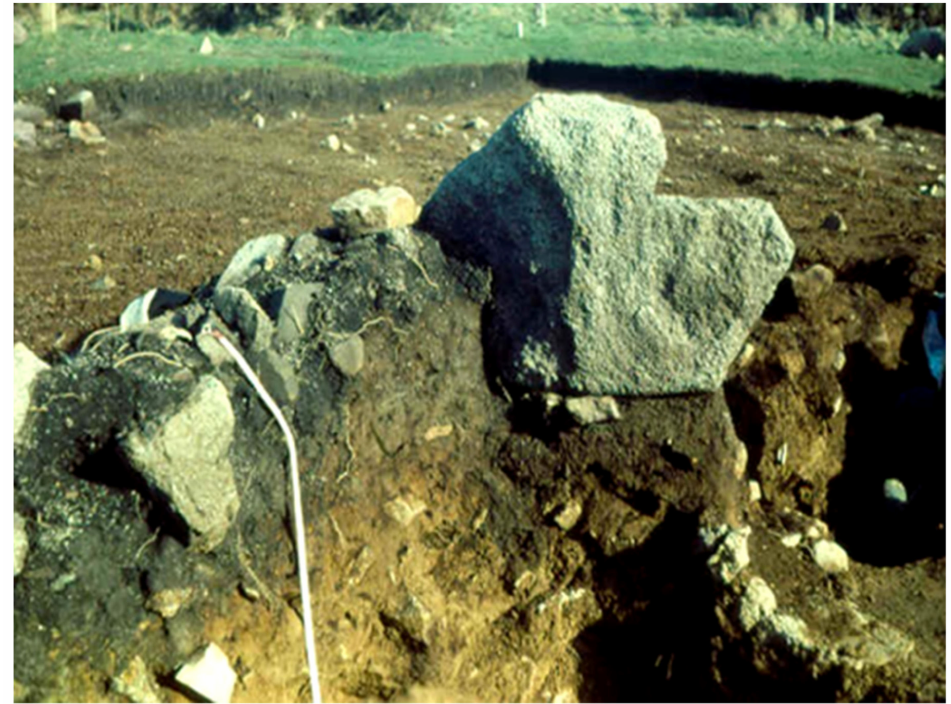
Figure 11. Original brown earth type forest soil preserved beneath a Bronze Age burial structure with a thin iron-pan podzol and peaty surface developed in the surface of the structure and peat accumu- lated in the surrounding area; Colliford, Bodmin Moor, southeast England. Source: Edward